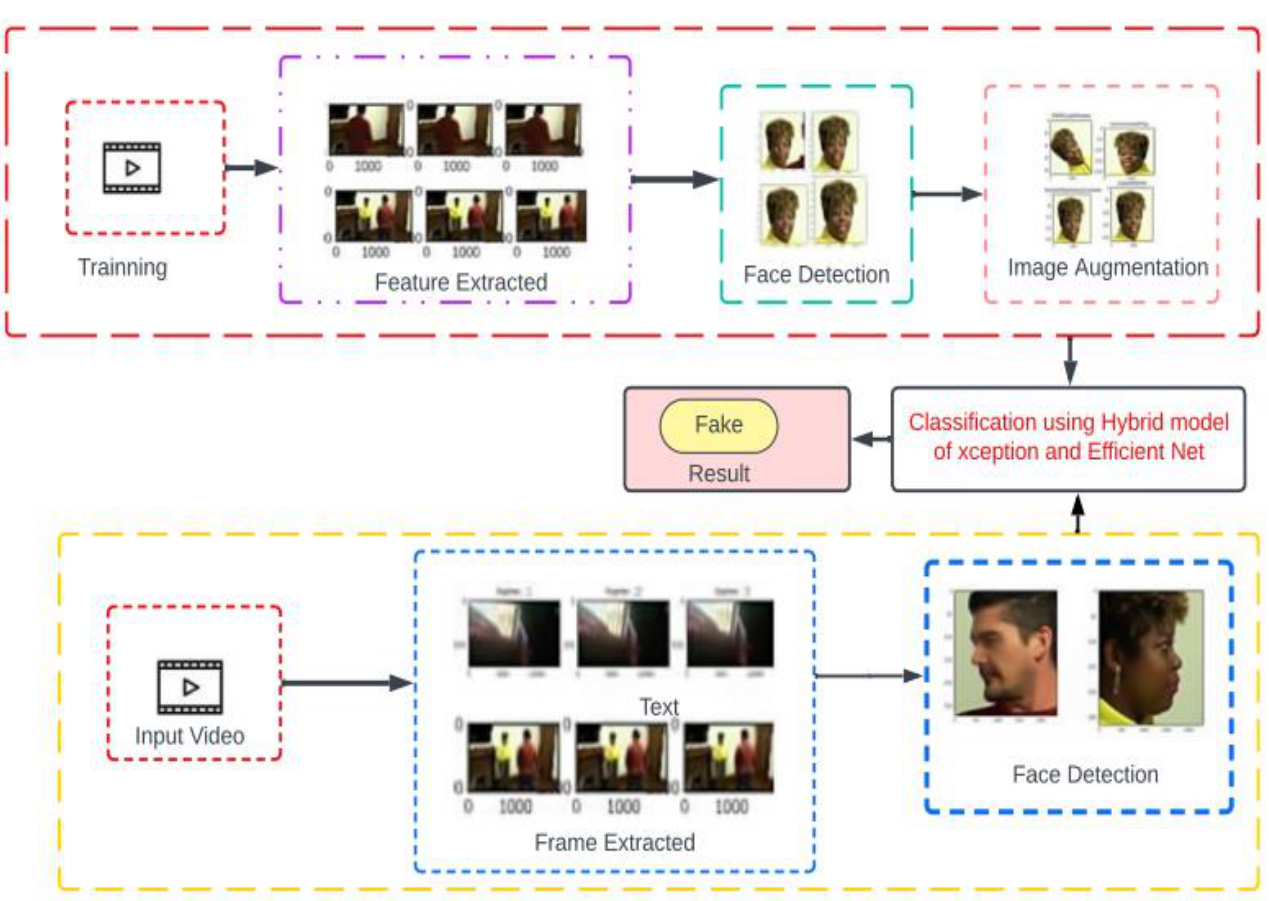
Figure 5. Flow chart of deep fake detection with a sample video.